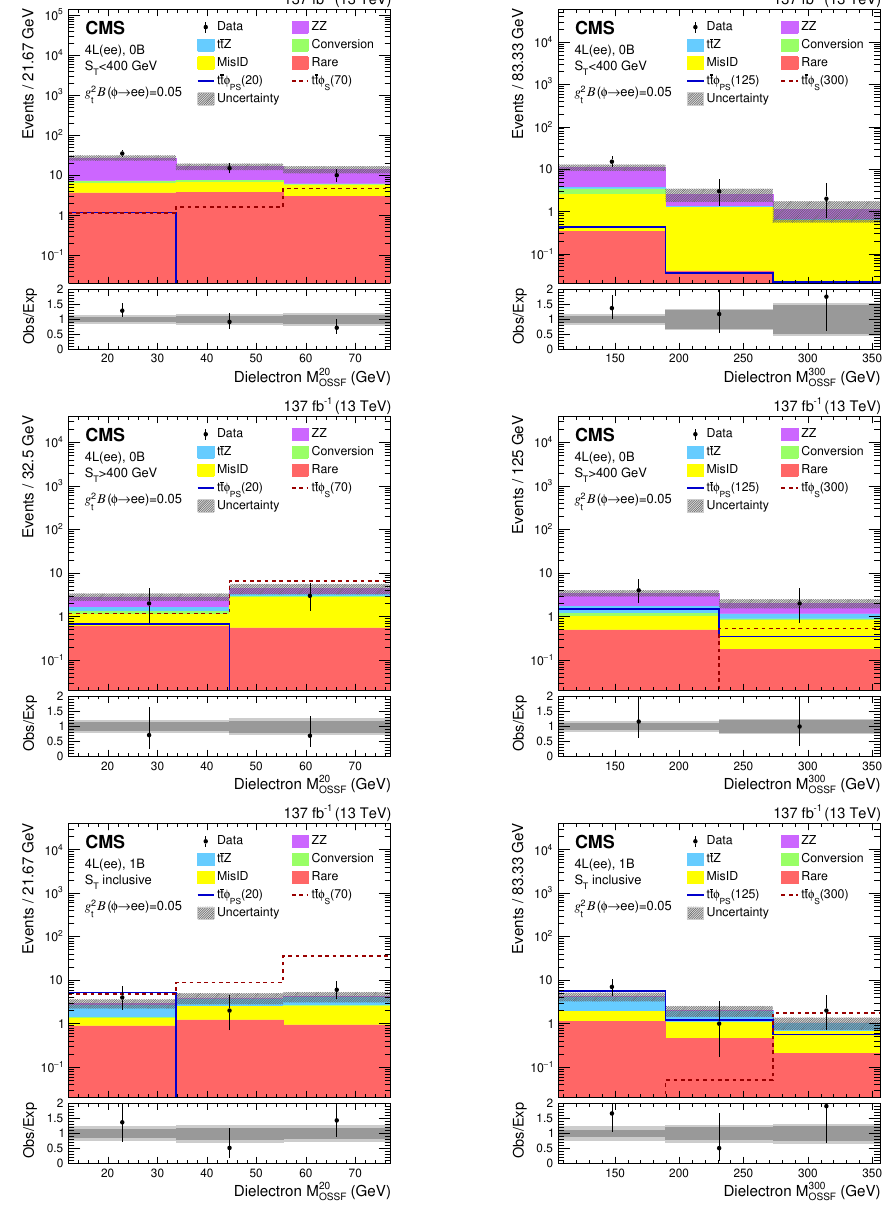
Figure 7 . Dielectron M 20 (left column) and M 300 (right column) distributions in the 4L(ee) OSSF OSSF tt (cid:30) signal regions. Upper, center, and lower plots are for 0B S < 400 GeV, 0B S > 400 GeV, T T and 1B S -inclusive, respectively. The total SM background is shown as a stacked histogram of all T contributing processes. The predictions for tt (cid:30) ( ! ee) models with a pseudoscalar (scalar) (cid:30) of 20 B ( (cid:30) ! ee) = 0 : 05 are also shown. The lower panels and 125 (70 and 300) GeV mass assuming g 2 t show the ratio of observed to expected events. The hatched gray bands in the upper panels and the light gray bands in the lower panels represent the total (systematic and statistical) uncertainty of the backgrounds in each bin, whereas the dark gray bands in the lower panels represent only the statistical uncertainty of the backgrounds. The rightmost bins do not contain the over(cid:13)ow events as these are outside the probed mass range.